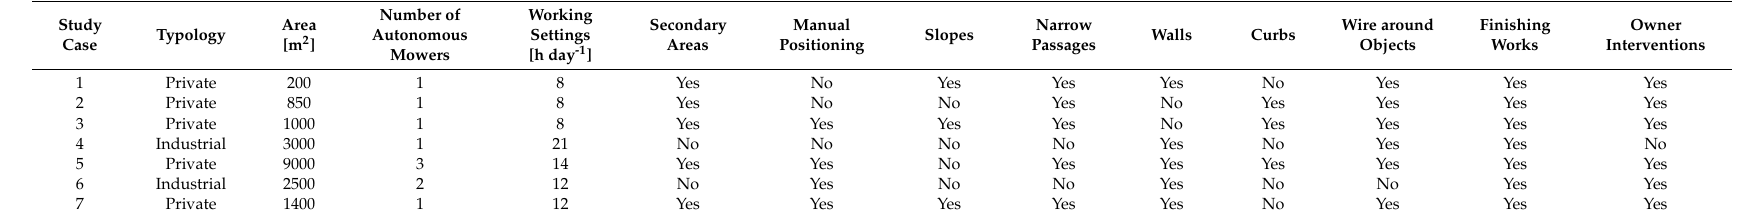
Table 2. Results of